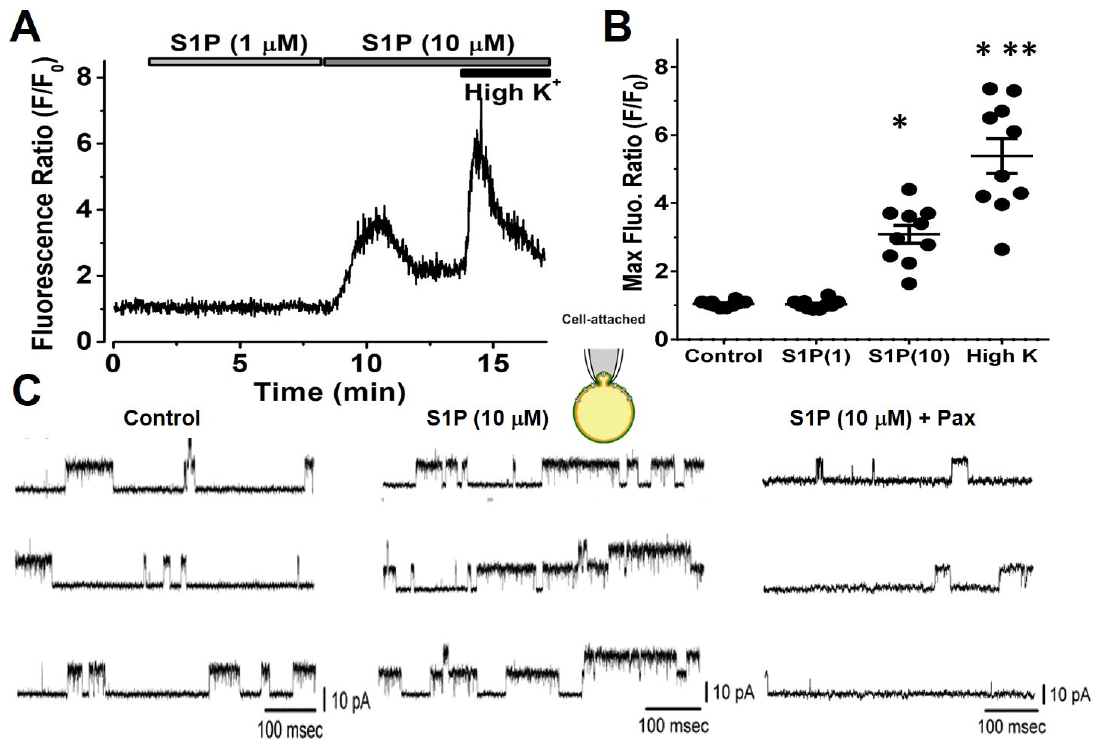
Figure 3. Effects of S1P (10 µ M) on Ca i and BK Ca activation of chromaffin cells. ( A ) Representative Ca i trace of the fluorescence ratio (340/380 nm) from an individual cell loaded with fura-2/AM. The cells were bathed in a normal Tyrode solution with 1.8 mM CaCl 2 . For Ca i , there was no change in the S1P (1 µ M) application but a high-dose S1P (10 µ M) elevated the Ca i transients and was further increased by high K + (45 mM) subsequently. ( B ) Summary of S1P effects on Ca i . Asterisks indicate significant differences ( p < 0.05, * control and ** 10 µ M S1P, n = 10, in four cultures). ( C ) S1P-enhanced BK Ca on a cell-attached patch (as inset) measured at +60 mV. The cells were bathed in a high-K + bathing solution with 1.8 mM CaCl 2 . BK Ca events were obtained in the control (left), S1P (10 µM, middle), and after paxilline (Pax, 1 µM, right) combined with S1P which were significantly suppressed.